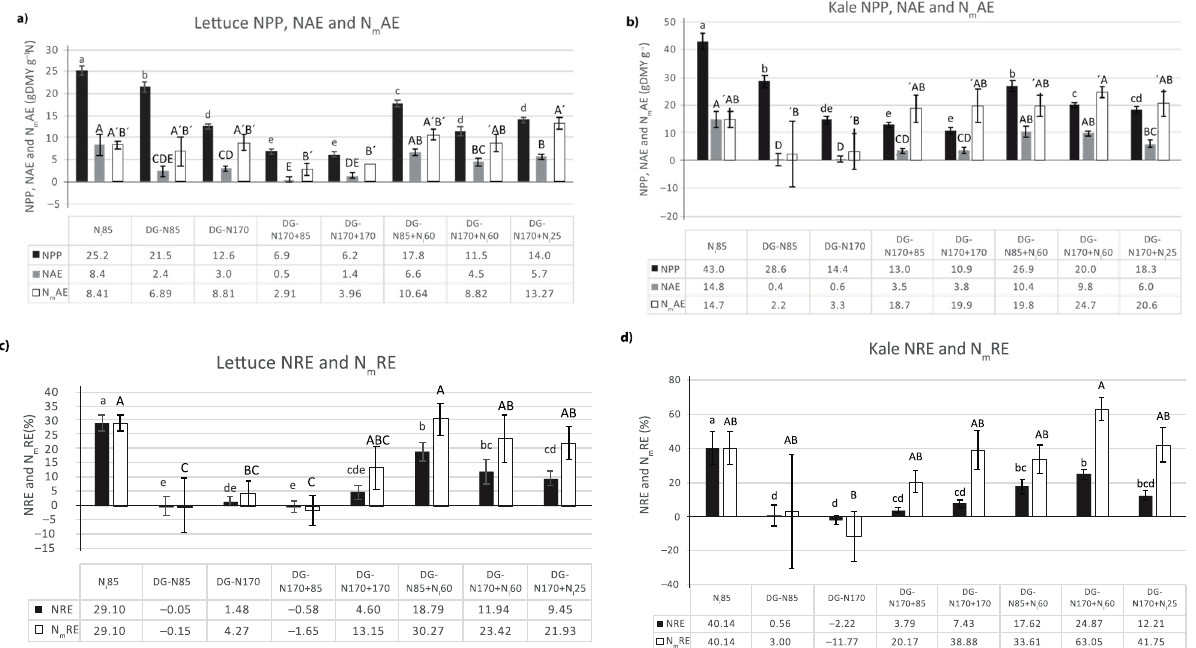
Figure 2. Nitrogen partial productivity (NPP, g DMY g − 1 N) and nitrogen agronomic efficiency (NAE, and N m AE, g DMY g − 1 N) of ( a ) lettuce and ( b ) kale, and nitrogen recovery efficiency (NRE and N m RE, %) of ( c ) lettuce and ( d ) kale. The data are presented as mean ± SE ( n = 4). According to Duncan’s multiple range test, different letters above the columns indicate statistically significant differences among the treatments for each nitrogen use efficiency indexes ( p < 0.05).